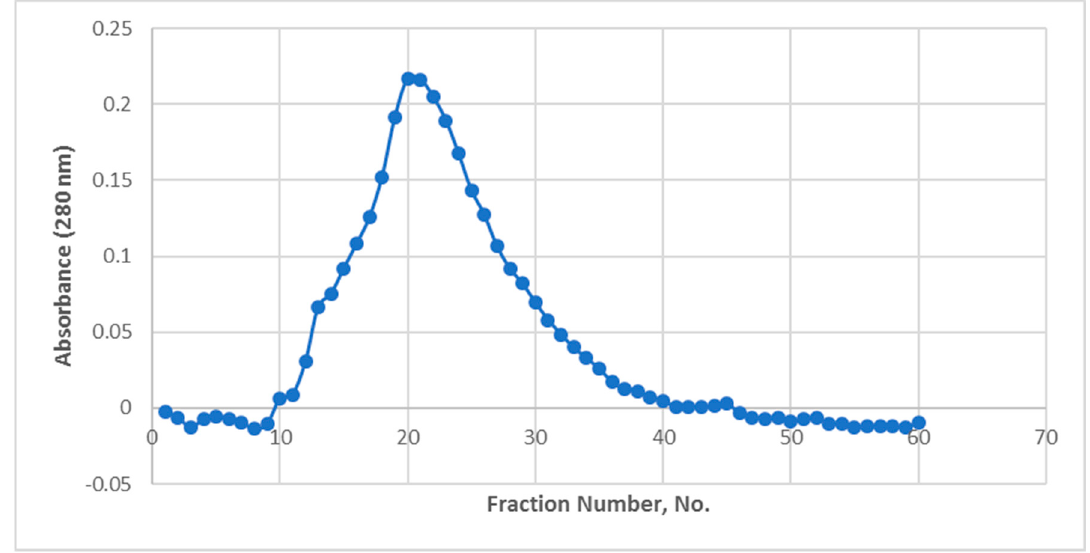
Figure 2. Elution profile for the GFC fractions of ‘Señorita’ banana protein partially purified at 40%–60% ammonium sulfate saturation.